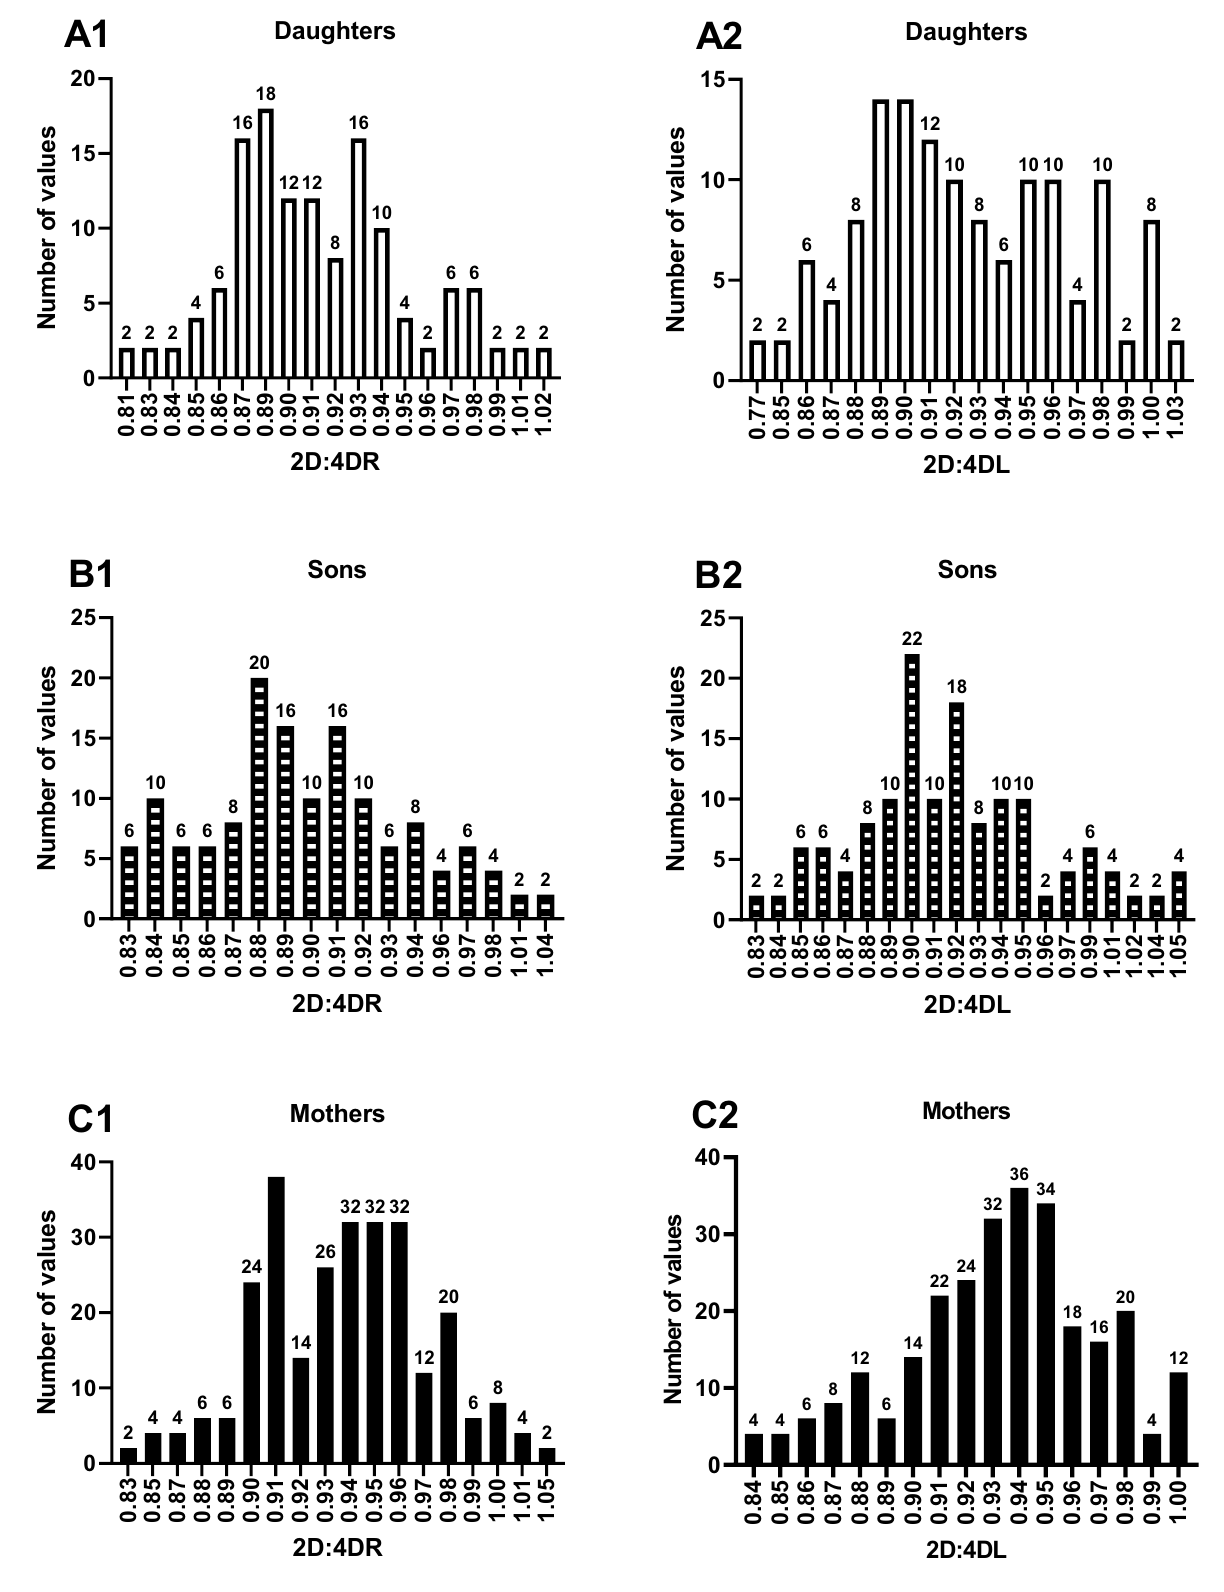
Figure 1. Frequency distribution bar graphs of digit ratios: distribution of digit ratios among daughters ( A1 = 2D:4DR, A2 = 2D:4DL), distribution of digit ratios among sons ( B1 = 2D:4DR, B2 = 2D:4DL), distribution of digit ratios among mothers ( C1 = 2D:4DR, C2 =